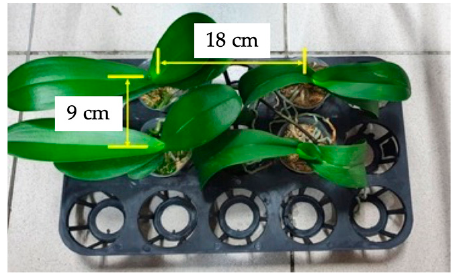
Figure 33. The pot holder for the multiple-seedling experiments.